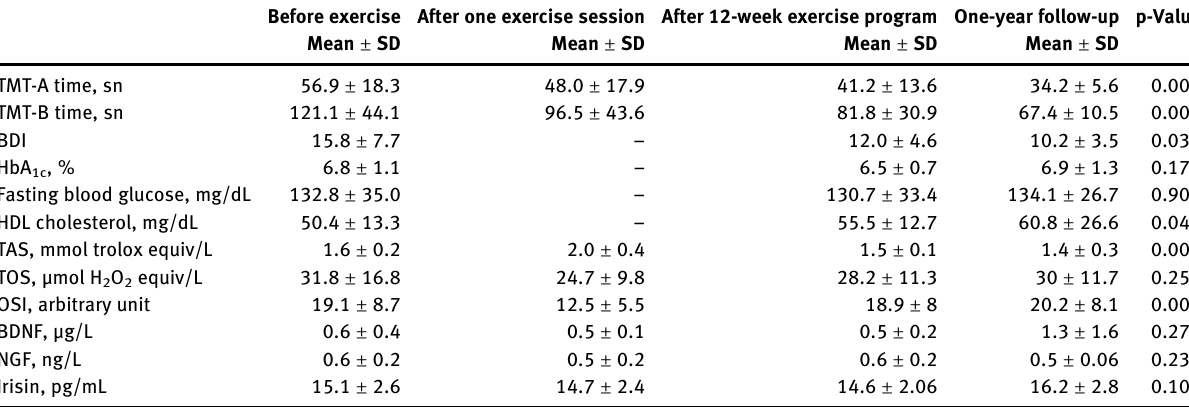
Table  : Results of cognitive and depression state tests and blood